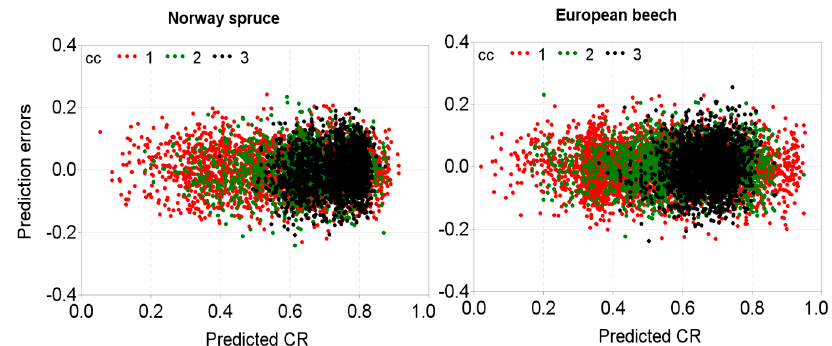
Figure 5. Prediction errors of the calibrated mixed-effects model using a part of the fitting dataset. The random effects were estimated using crown ratio measurements from a sub-sample of four randomly selected trees of the species of interest per sample plot and localized (calibrated) mixed-effects CR model. (CC = canopy height class 1: height greater than 66% of the tallest tree, 2: height between 33% and 66% of the tallest tree, and 3: height less than 33% of the tallest tree.